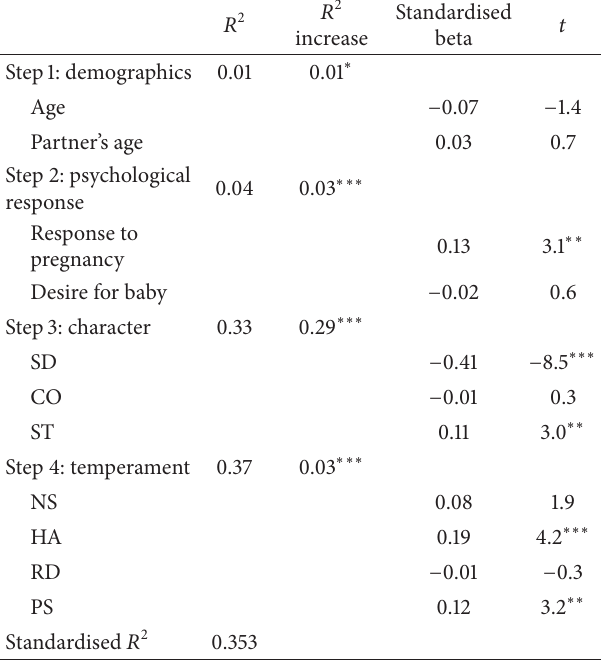
Table 2: Hierarchical multiple regression analyses predicting EPDS score during